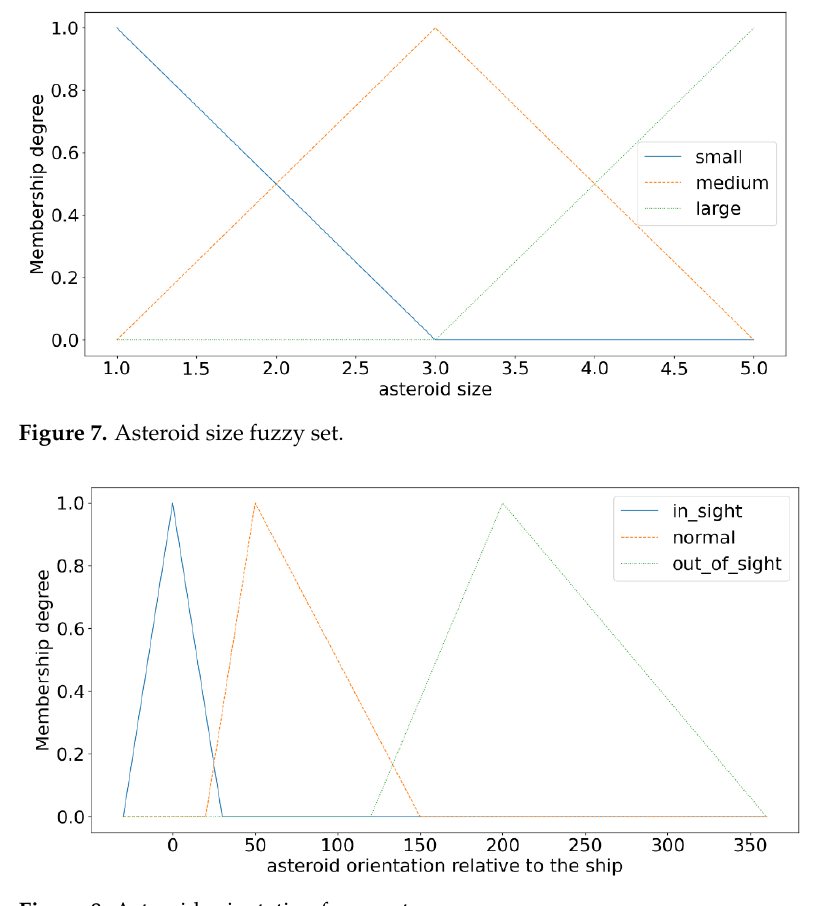
Figure 8. Asteroid orientation fuzzy set.